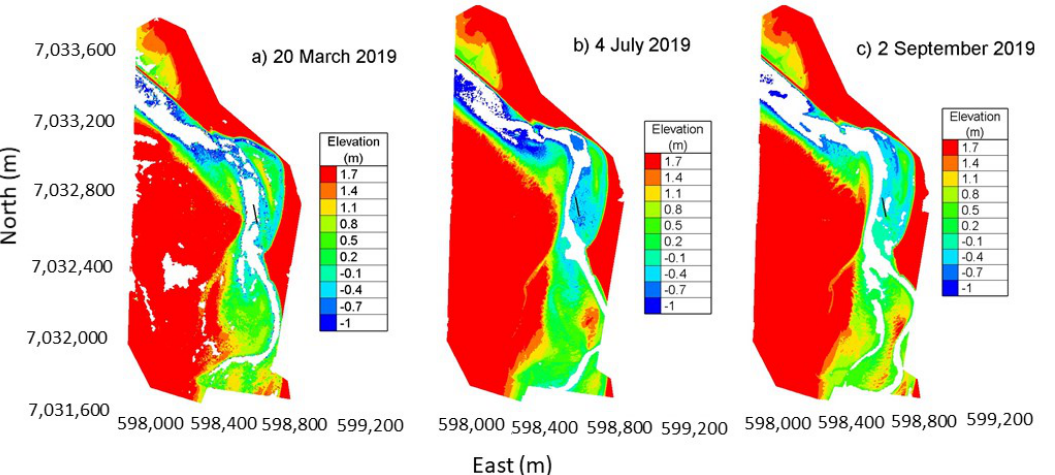
Figure 3. Topographic surveys by drone: ( a ) at 20 March 2019; ( b ) at 4 July 2019 and ( c ) at 2 September 2019. SND was installed 27 March 2019 indicating by the black line.